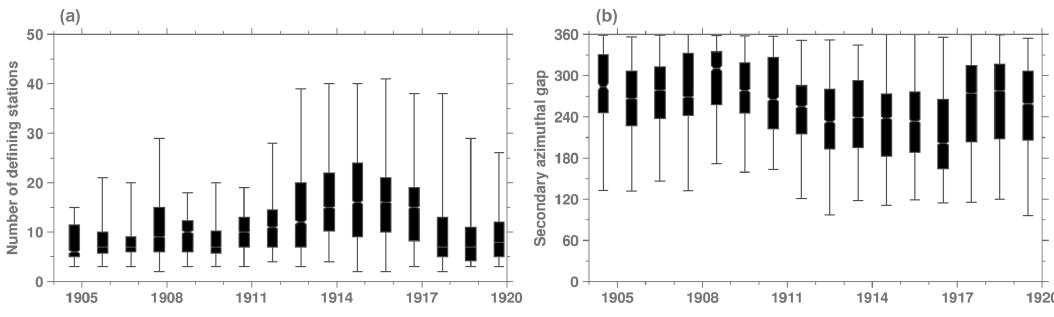
Figure 16. As for Fig. 7 but for the period 1904–1919.